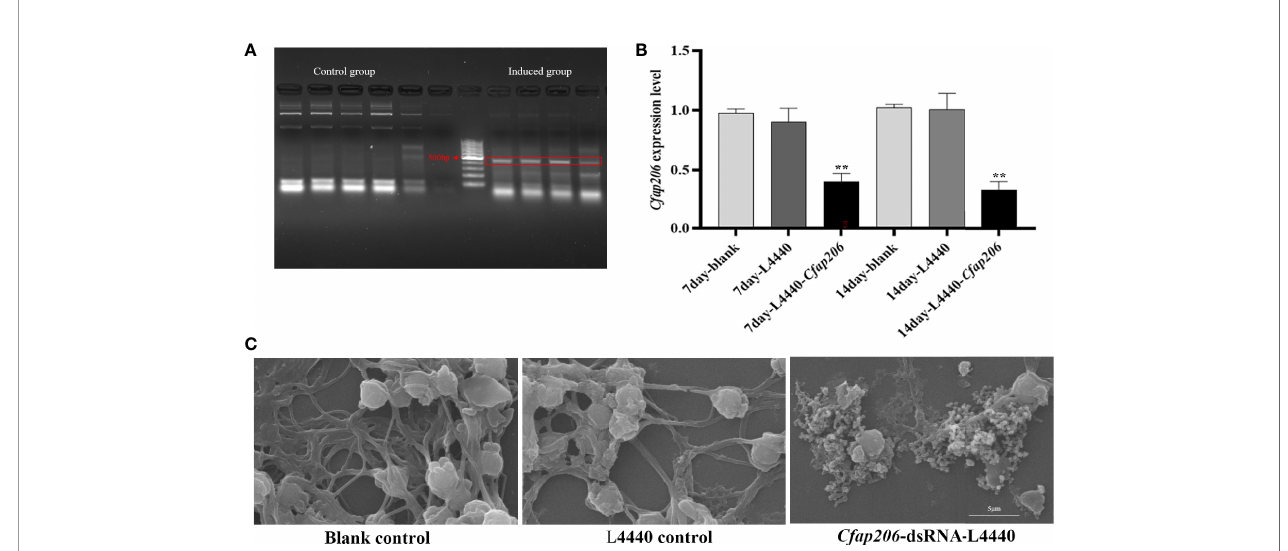
FIGURE 5 | Expression analysis of Cfap206 and morphological observation of sperm after RNAi. (A) Electrophoresis results of dsRNA induced by L4440- Cfap206 . Lanes 1 – 5, control group; lanes 8 – 11, induced group; and lane 7, 100 bp DNA ladder. (B) The expression of Cfap206 on days 7 and 14. ** p < 0.01. (C) Sperm morphology observation using